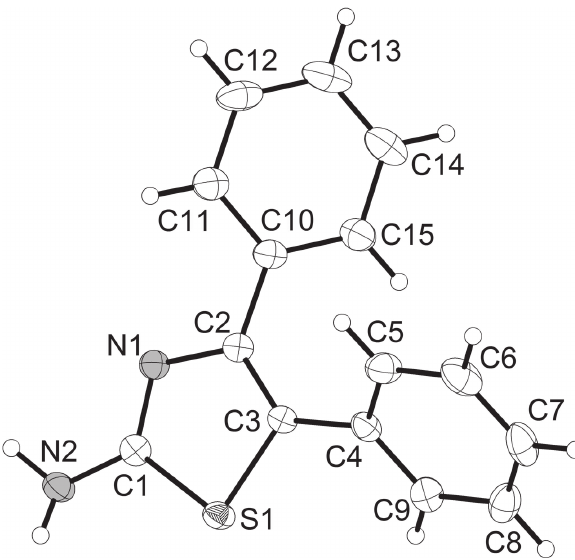
Table 1: Data collection and handling.